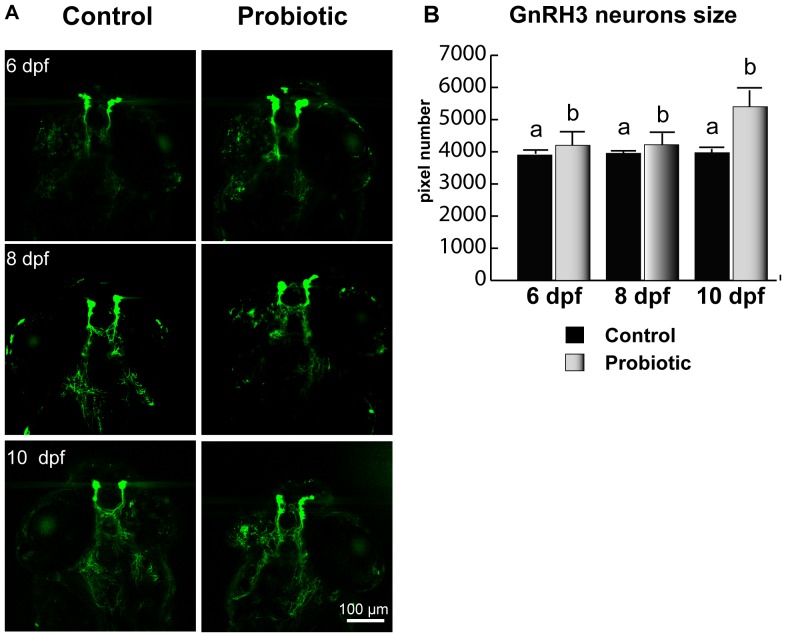
GnRH3 neurons soma size.GnRH3 neurons in transgenic zebrafish larvae (n = 10) sampled at 6, 8 and 10 dpf (A). Assay was conducted in triplicate. On the right, GnRH3 neurons size (pixels) (B). The green channel of RGB images collected at magnification of 20X (whose some representative are shown here) was extracted, converted to grayscale and GnRH3:EGFP neurons were analyzed for size using the “Analyze > Analyze particles…” macro. We set up the macro-assisted algorithm to exclude the background pixelation. At 6, 8 and 10 dpf, 10 fish were analyzed for each experimental condition. Values with different superscript letters are significantly different (P<0.05).